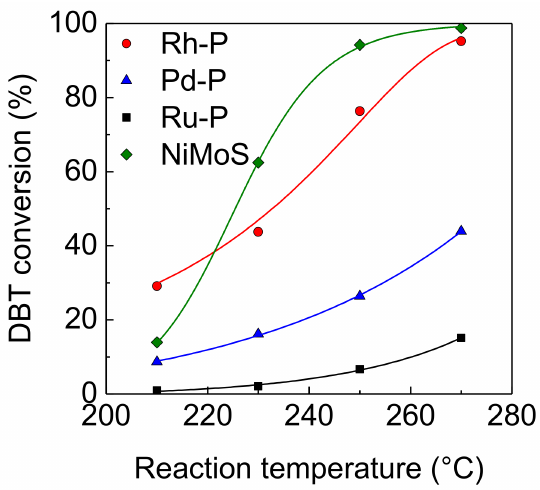
Figure 2. Effect of reaction temperature on the activities of NM-P and NiMoS catalysts for the hydrodesulfurization (HDS) of